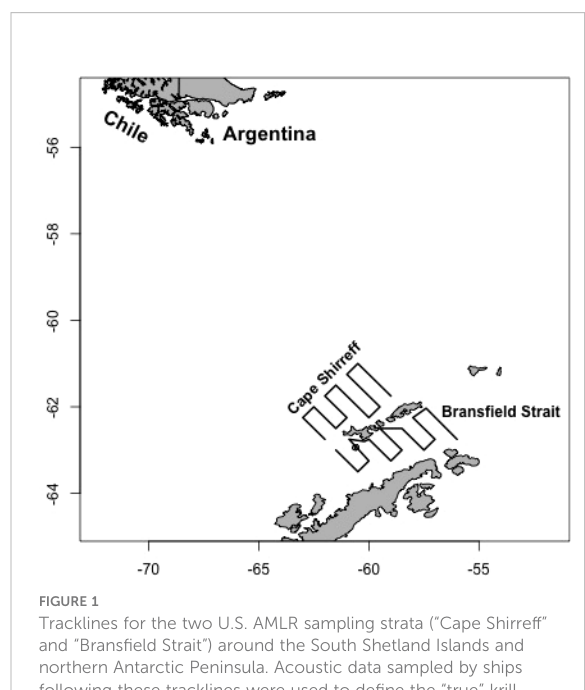
FIGURE 1 Tracklines for the two U.S. AMLR sampling strata ( “ Cape Shirreff ” and “ Brans fi eld Strait ” ) around the South Shetland Islands and northern Antarctic Peninsula. Acoustic data sampled by ships following these tracklines were used to de fi ne the “ true ” krill populations in each of ten years for each stratum. These data were subsequently sampled by the simulated